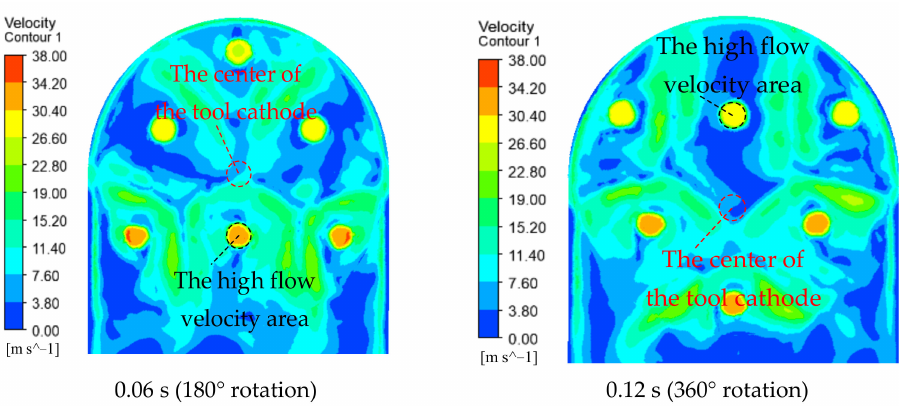
Figure 5. Electrolyte velocity distribution in the machining gap at different times using tool B.